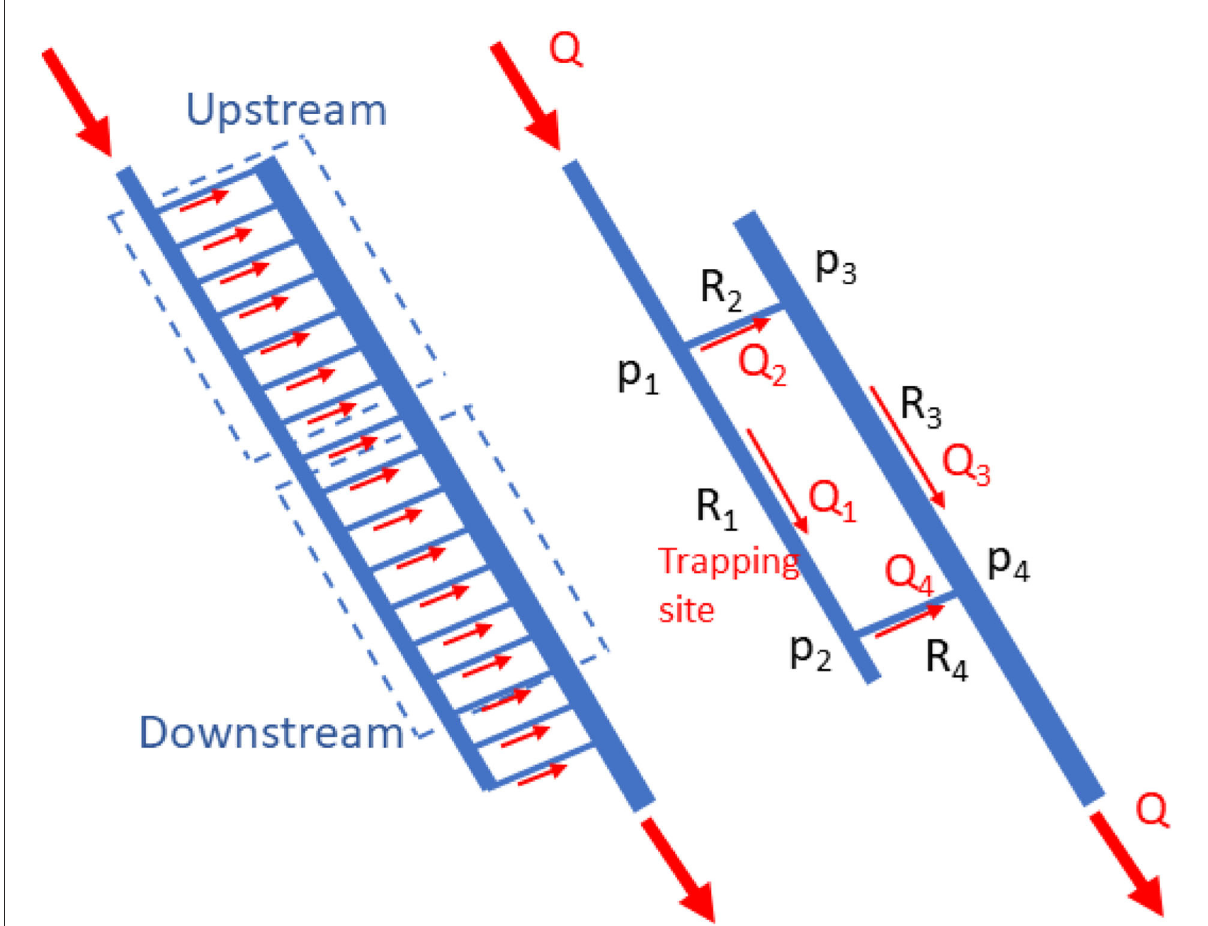
FIGURE2 Simplified mathematical model for the two groups of micro-capillaries passing into the upstream and downstream micro-capillary.